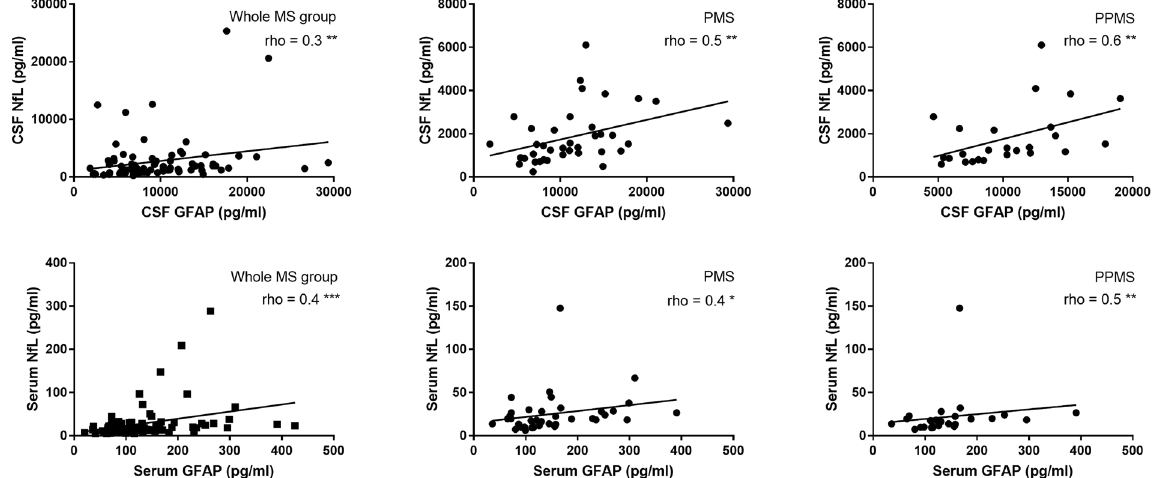
Figure 4. Spearman correlation (rho) between glial fibrillary acidic protein (GFAP) and neurofilaments light (NfL) in cerebrospinal fluid (CSF) and serum in the whole multiple sclerosis (MS), progressive (PMS) and primary progressive (PPMS) patients. * p < 0.05, ** p < 0.01, *** p < 0.001.